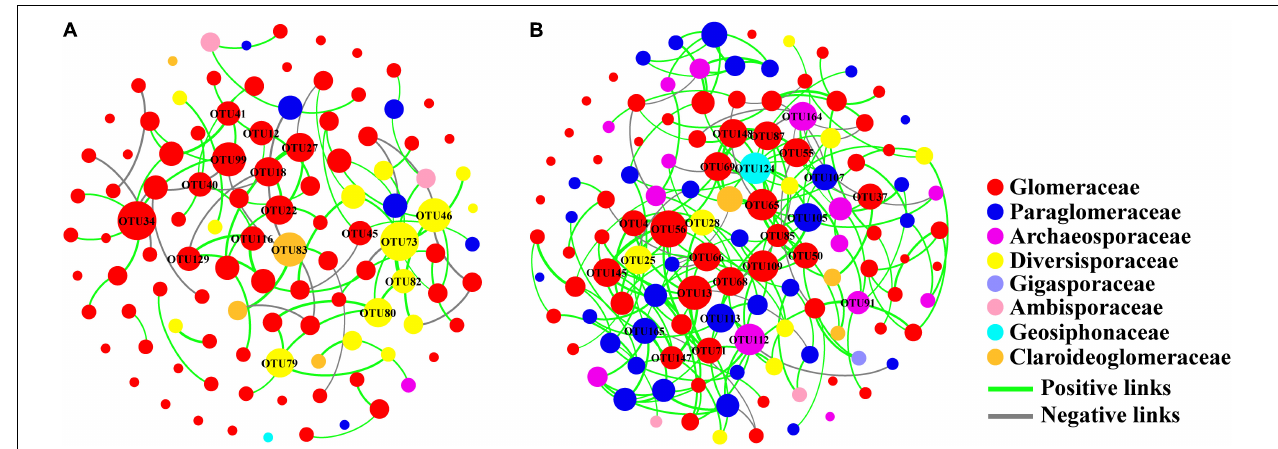
FIGURE 6 | Network diagram of AM fungal community on conventional (A) and organic (B) maize farms. The size of each node is proportional to the number of connections (degree).